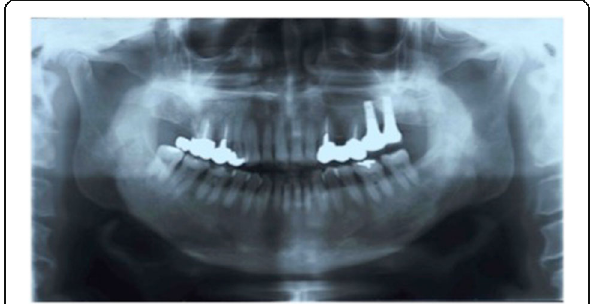
Fig. 7 Nine-year follow-up radiograph of the